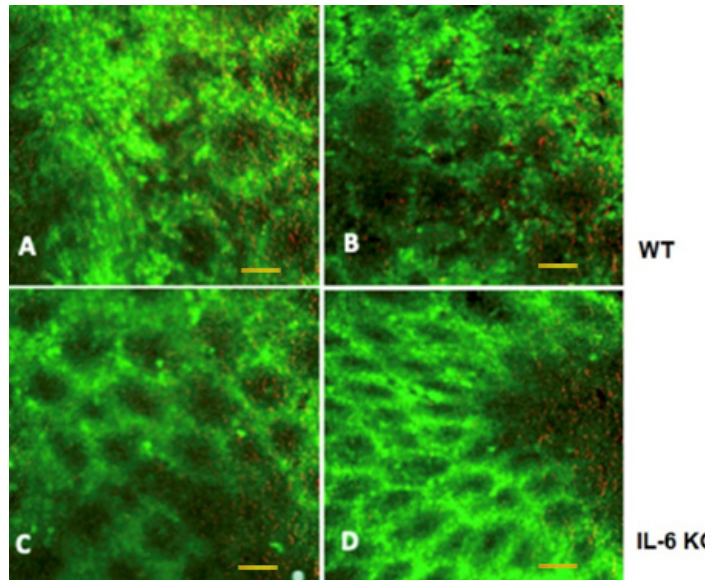
Figure 6. Intraluminal fluorescent endomicroscopic images of WT and IL-6 KO mouse colon. ( A ) In vivo intraluminal image; ( B ) ex vivo mucosal surface image in a WT mouse with colonic tumor; ( C ) in vivo intraluminal image; ( D ) ex vivo mucosal surface image in an IL-6 knockout mouse with inflammation-related colonic neoplasia. 488 nm (green) and 660 nm (red) dual band fluorescent Cellvizio endomicroscopic images. Scale bar represent 50 microns for all